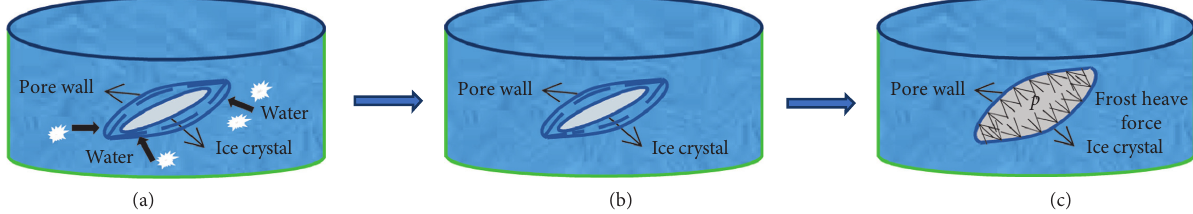
Figure 14: Diagram of water migration in the sample and the effect of ice on the pore wall: (a) migration of water; (b) frozen shrinkage; (c) frozen shrinkage and frost